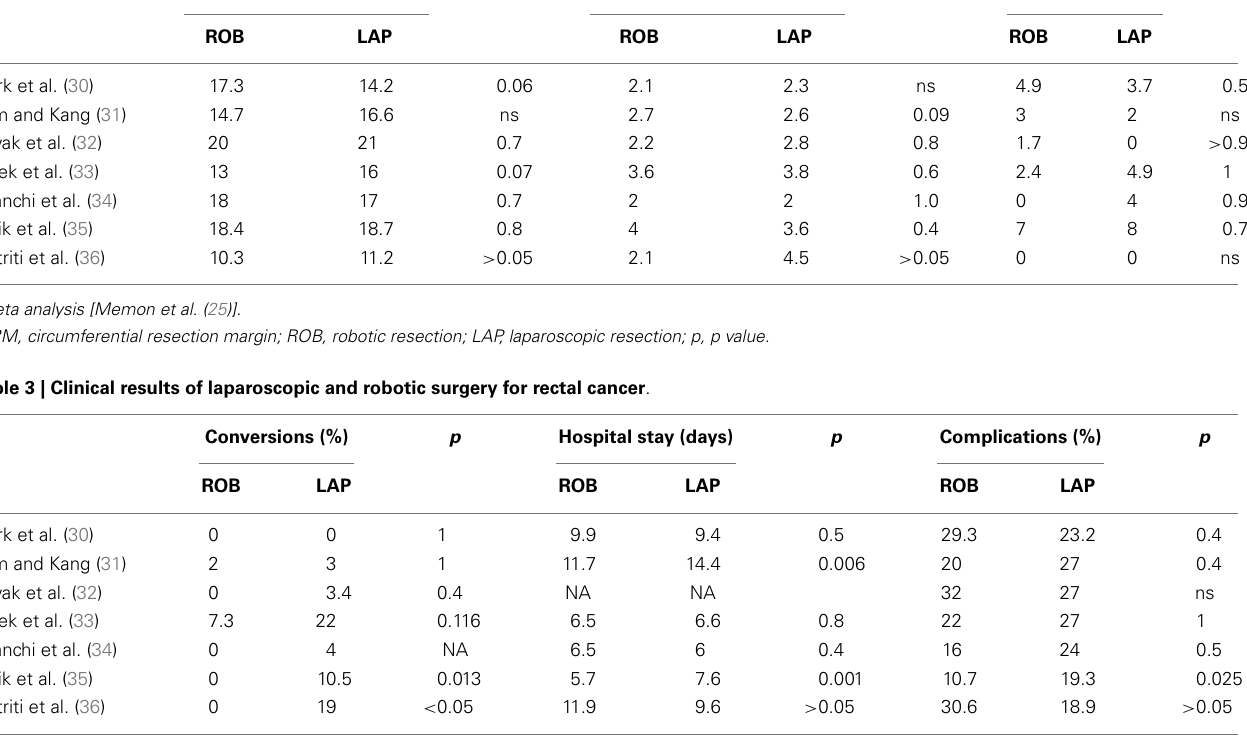
Table 2 | Oncologic results of laparoscopic and robotic surgery for rectal cancer . Harvested lymph nodes ( n ) p Distal resection margin (cm)